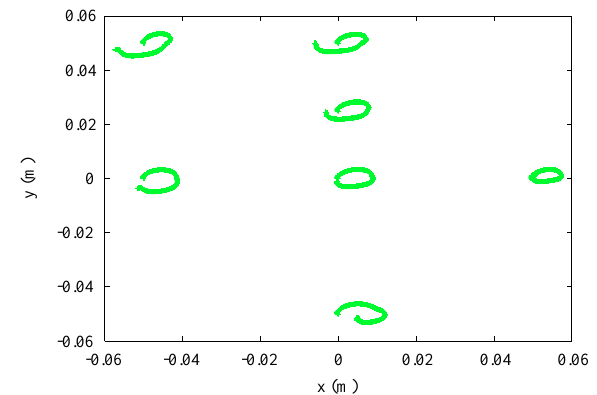
FIG. 13. (Color) A two-dimensional projection of the tracks shown in Fig. 12. The ( (cid:120)(cid:121) ) projections show a clockwise drift combined with a horizontal or vertical displacement which depends on the initial position.